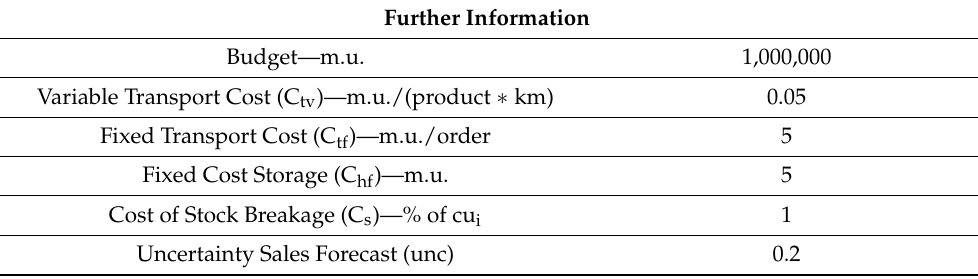
Table 9. Other relevant model